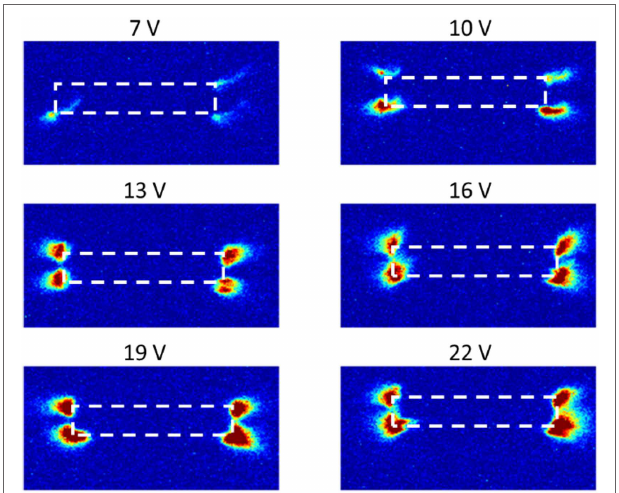
FIGURE 11 | The cooling effectiveness of the two piezoelectric shapes as a function of the applied voltage